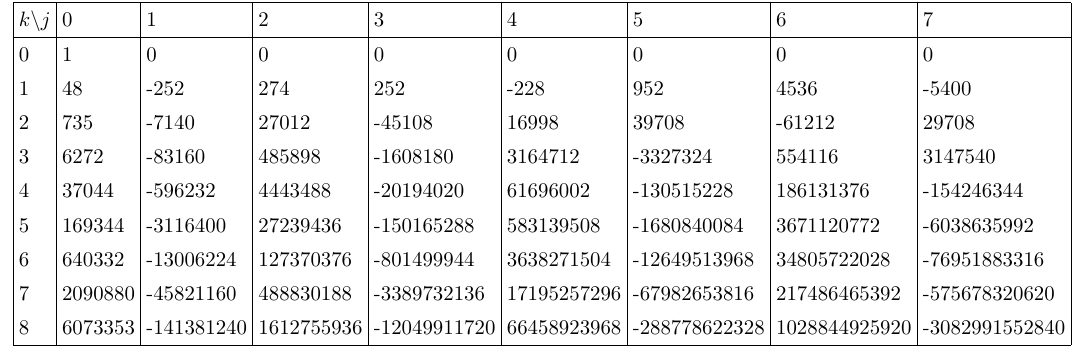
Table 31. Table of b jk coe(cid:14)cients for h SU(7)